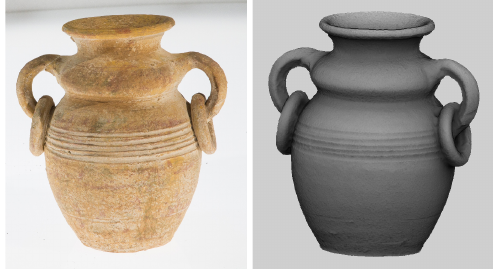
Figure 9: One (out of 31) synchronized image of a small vase obtained with the DI-One system (left) and the reconstructed 3D mesh